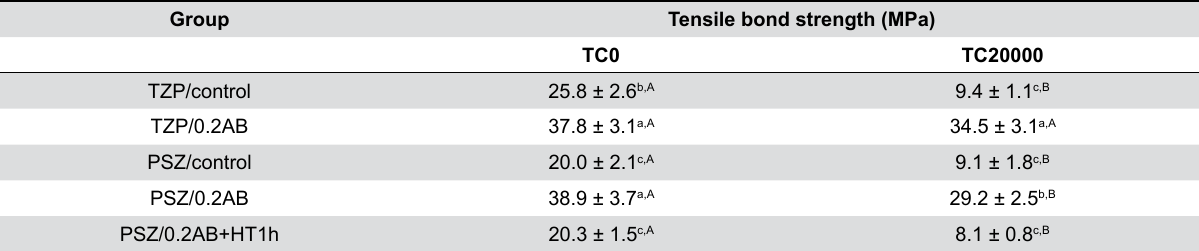
Influence of alumina air-abrasion for highly translucent partially stabilized zirconia on flexural strength, surface properties, and bond strength of resin Table 2- Tensile bond strength of resin cement to highly translucent TZP and PSZ after air-abrasion with alumina and/or additional heat treatment